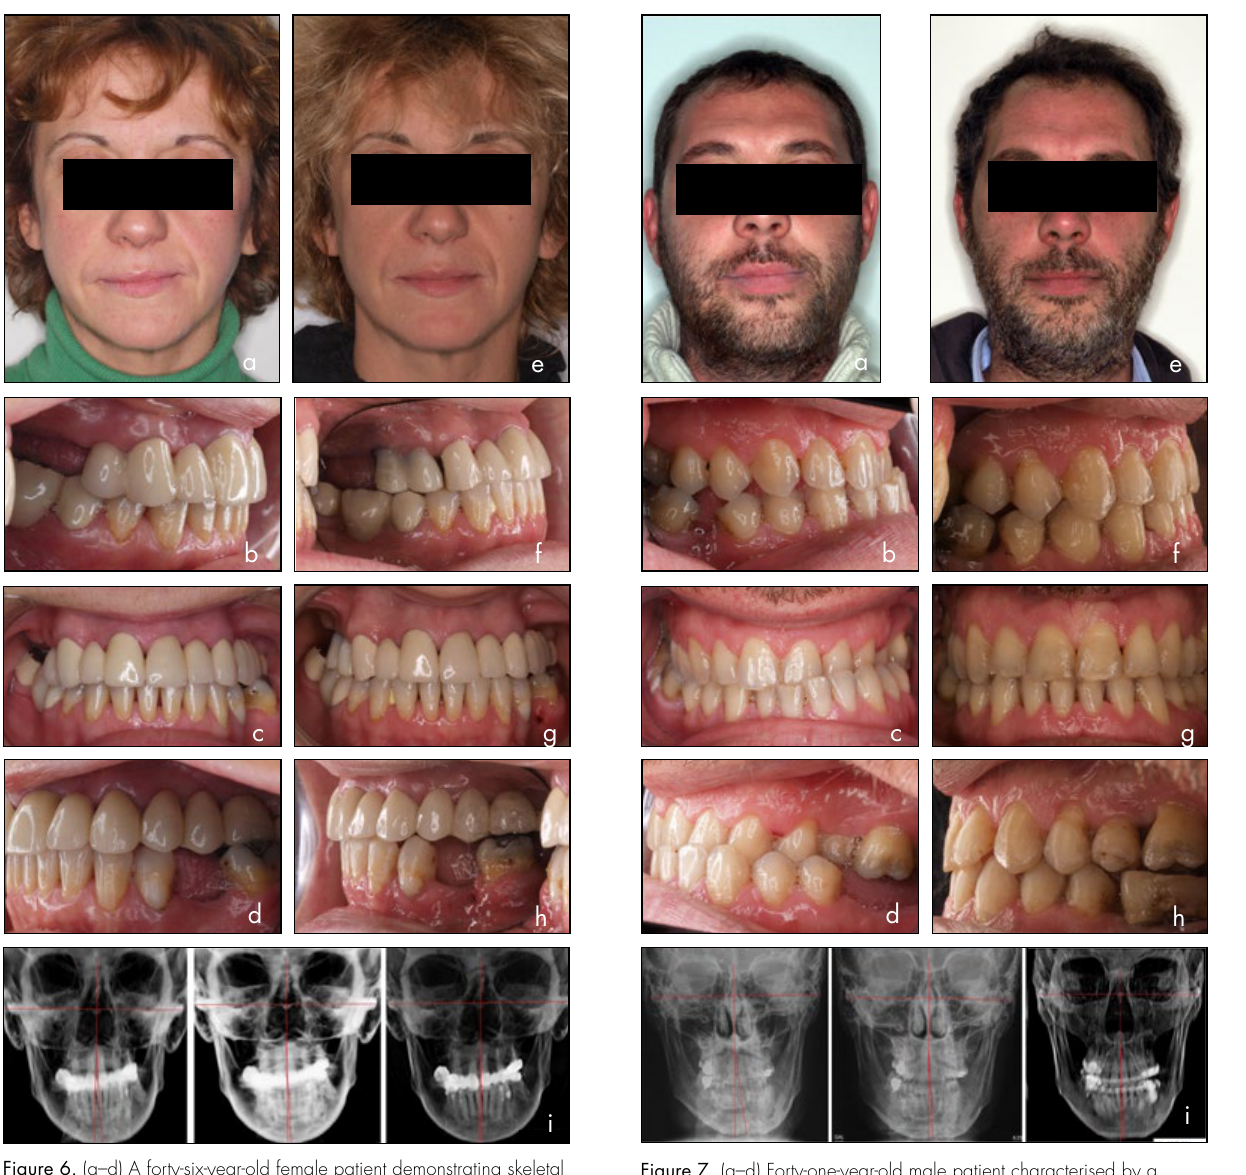
Figure 7. (a–d) Forty-one-year-old male patient characterised by a severe asymmetry with a deviation of the mandible to the left and a full cross bite on the same side. A Class III molar relationship was present on the right side. (e-h) The patient’s mandible was repositioned to the right and orthodontic treatment was also performed including an asymmetric upper expansion and lower contraction in the right side, transverse leveling of the occlusal plane and space closure on the lower right quadrant by anterior retraction. Implants were placed in the lower left quadrant. Following treatment, the facial symmetry was improved, and a centered occlusion with the midlines centered and a Class I canine relation was achieved on the right side. Temporary crowns were still present on the implants. (i) The frontal radiographs demonstrated the changes and at T2 also the inserted implants. (j–l) Eight months from treatment start, the mandible was repositioned and the midlines were coincident. The disocclusion, due to repositioning, had contributed to the Class III correction. Once the transversal position has been accepted and stabilised, the following treatment consisted mostly of the sagittal correction, in which the implants used to replace teeth 3.6 and 3.7 were used as